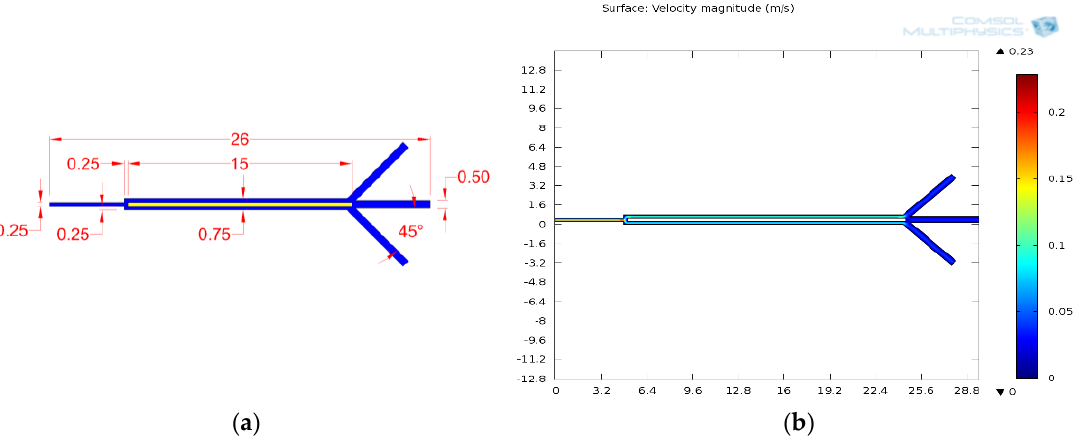
Figure 7. ( a ) The proposed microfluidic channel architecture for MAP and ( b ) its surface velocity plot.